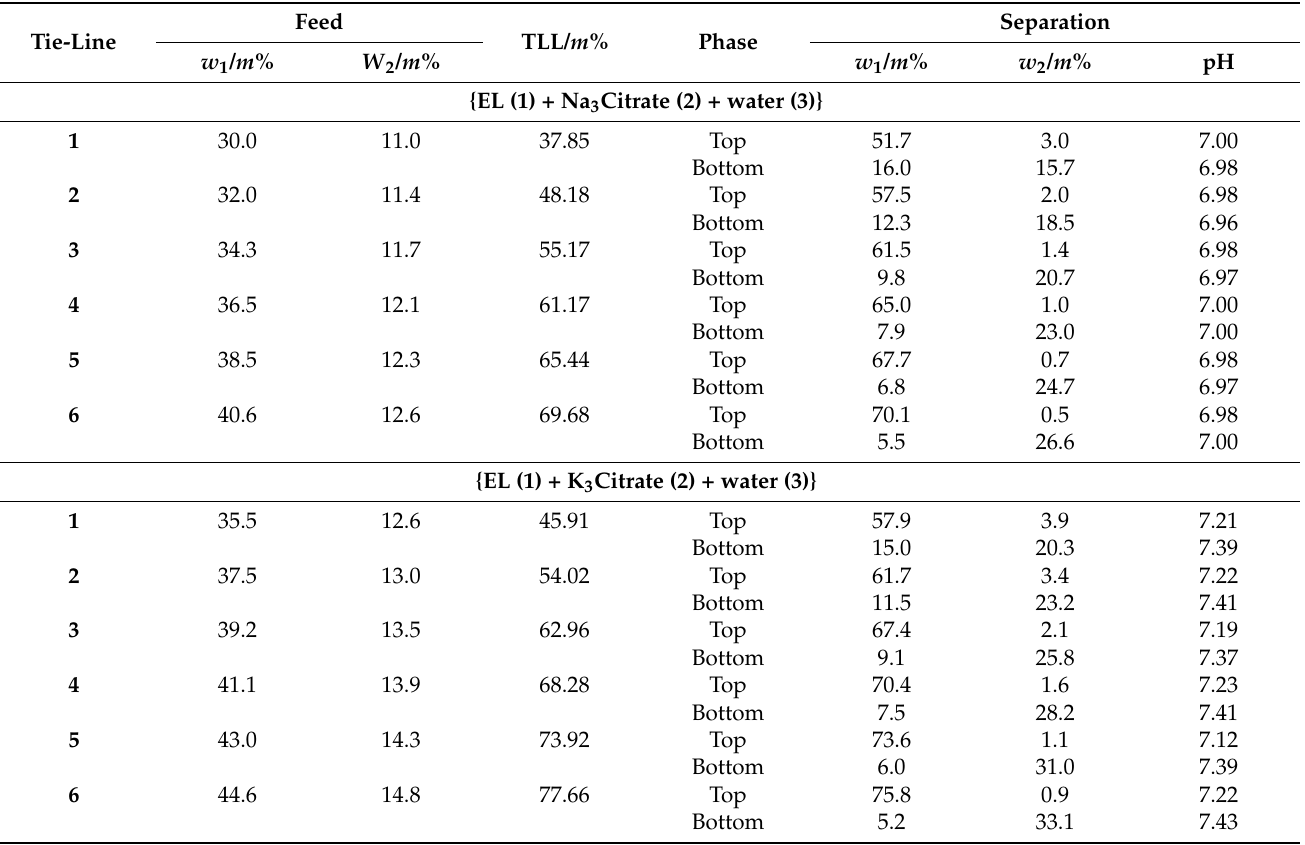
Table 2. Determined tie-lines for the ATPS {ethyl lactate (1) + trisodium citrate or tripotassium citrate (2) + water (3)} at 298.15 K and 0.1 MPa a,b